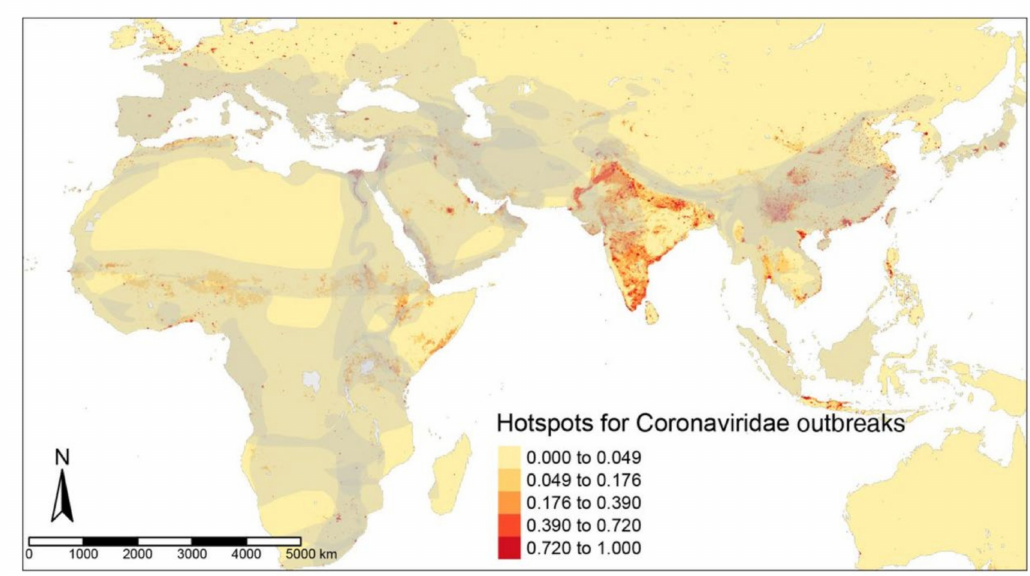
Figure 2. Predictive risks of Coronaviridae disease emergence modeled from the ZIB iCAR model with a spatial distribution of the mammalian reservoirs in grey.